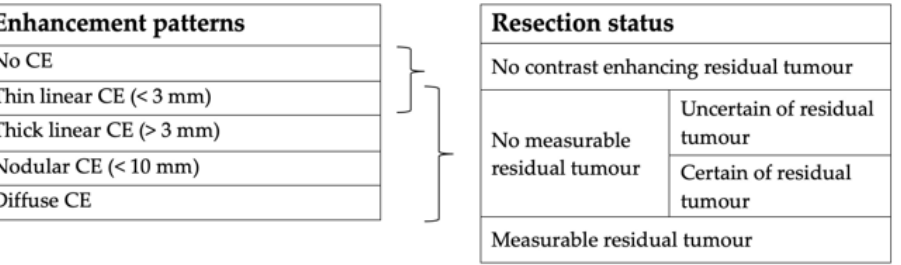
Figure 1. Overview of the data categorisation process. Enhancement patterns are specified in the left table with corresponding resection status specified in the table to the right. Several types of contrast enhancements could be present in one patient. Abbreviations: contrast enhancement (CE).